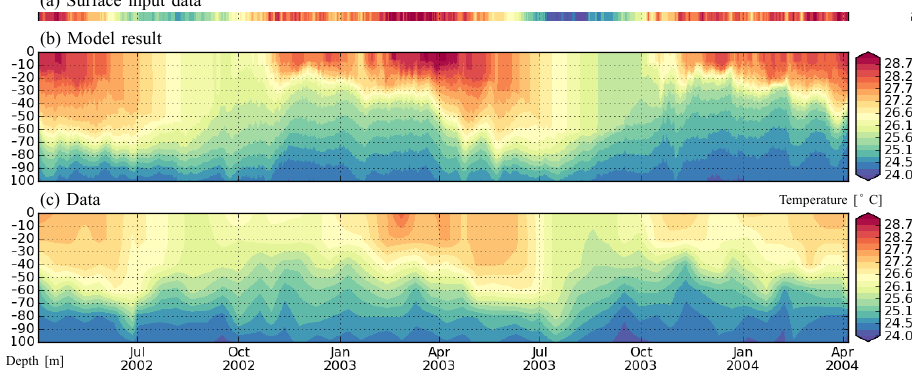
Figure 16. Lake water temperature ( ◦ C) at Kigoma as predicted by the model (b) and from in situ observations ( c , Descy et al., 2006). Panel (a) shows the surface temperature used to force the temperature flux at the lake surface (Thiery et al.,